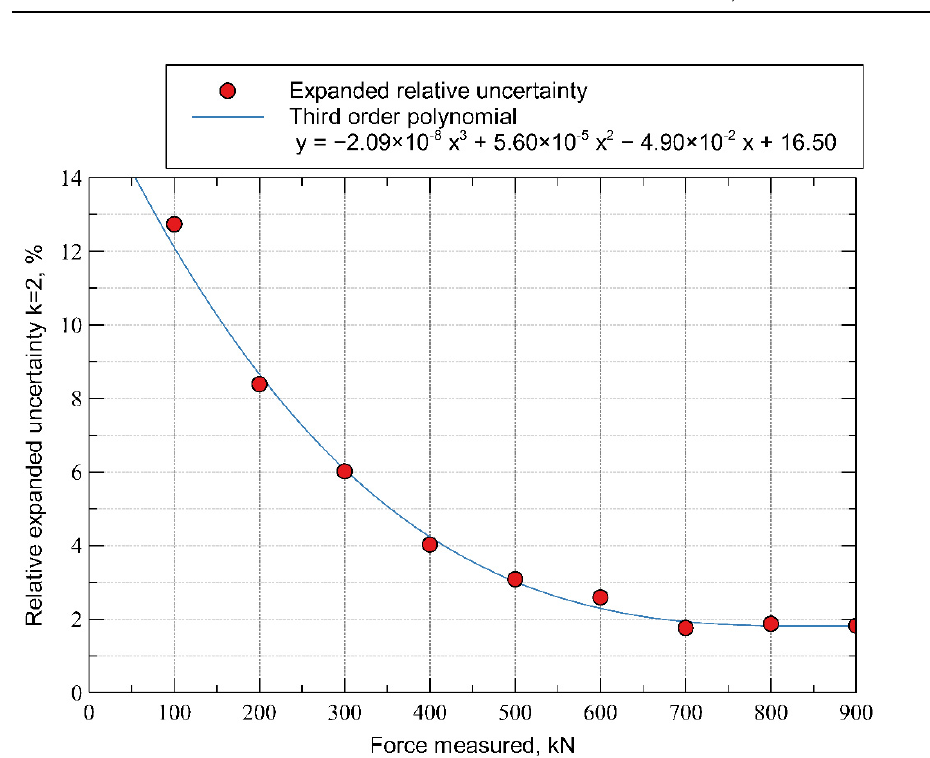
Figure 10. Calculated relative, expanded uncertainty errors in calibration levels.